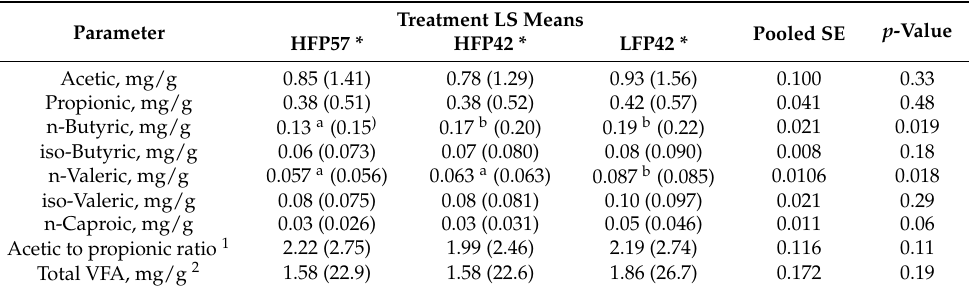
Table 3. Effect of three lamb-rearing treatments (HFP57, high fibre concentrate pellets and milk feeding to 57 d of age; HFP42, high fibre concentrate pellets and early weaning at 42 d of age; LFP42, low fibre concentrate pellets and early weaning at 42 d of age) on volatile fatty acid (VFA) content of rumen fluid from artificially reared lambs at slaughter (SE, standard